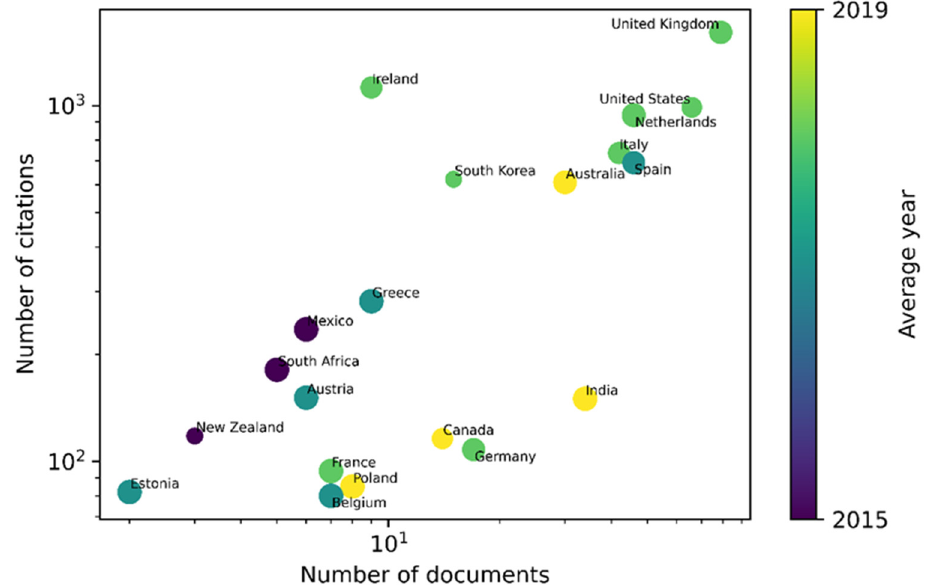
Figure 3. Most relevant countries by number of documents and citations in SPG research (1999– 2021). Note: Additional information is provided by the size of a circle reflecting the share of smart